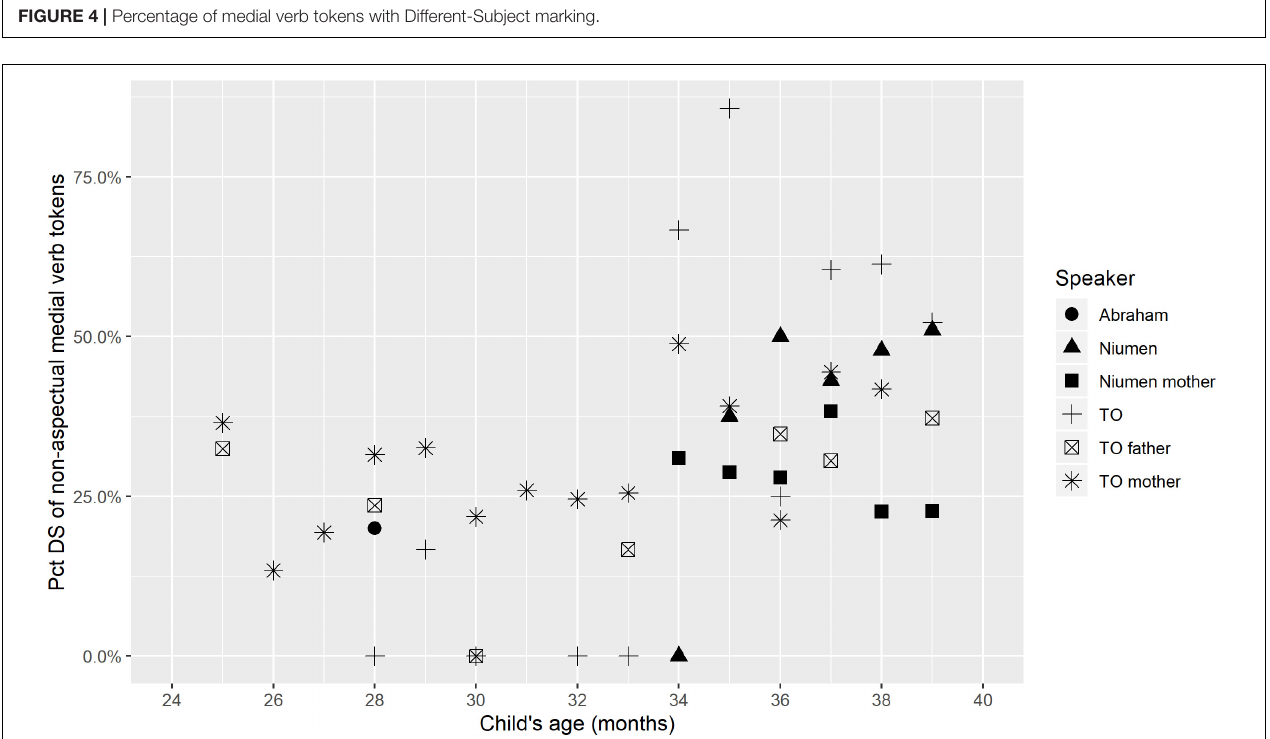
FIGURE 5 | Percentage of non-aspectual medial verb tokens with Different-Subject marking.